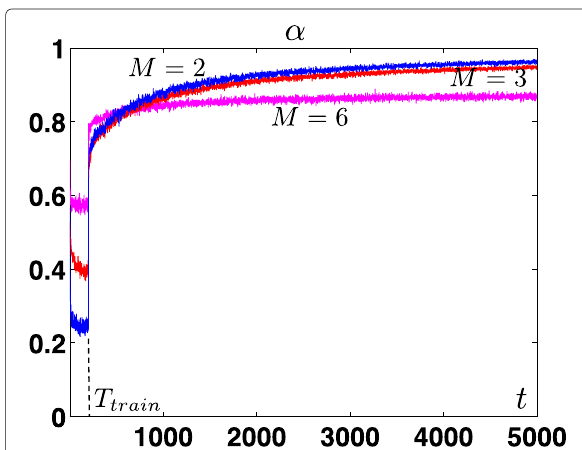
Fig. 1 Averaged values of the acceptance probability, α t , as function of the iteration index t and different values of M ∈ { 2,3,6 } , for the univariate Gaussian target in Section 6.1, using the AGM-MH algorithm. For t > T train , α t grows as a result of the adaptation of the proposal, which becomes closer to the target